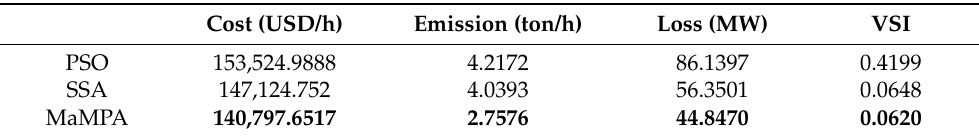
Table 15. Best compromised solutions for solving the MaOPF problem by using all considered objectives as the objective functions in the IEEE 118-bus system (case